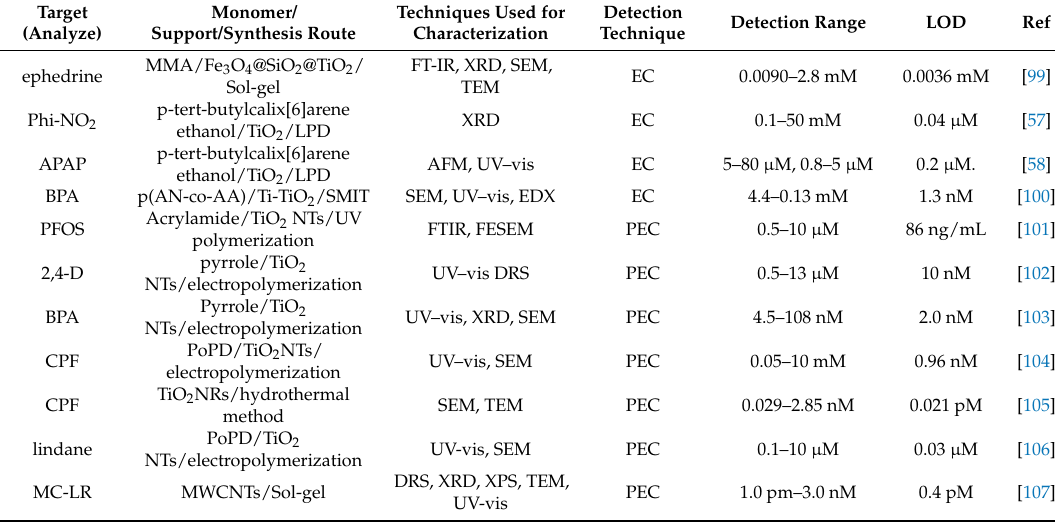
Table 3. Applications of MIPs modified TiO 2 nanomaterials for sensors